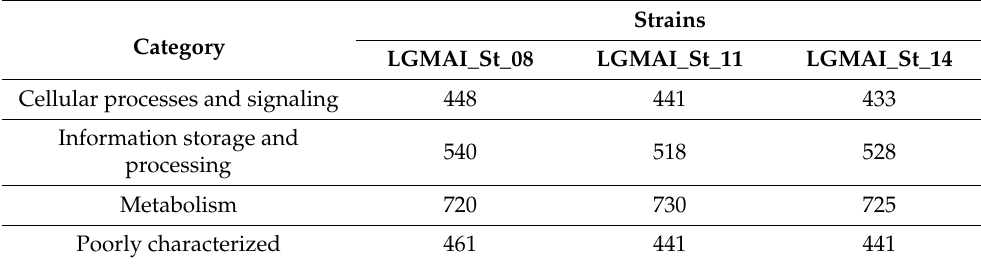
Table 11. Distribution of the orthologous groups identified by the eggNOG-mapper tool among the 4 major COG categories.